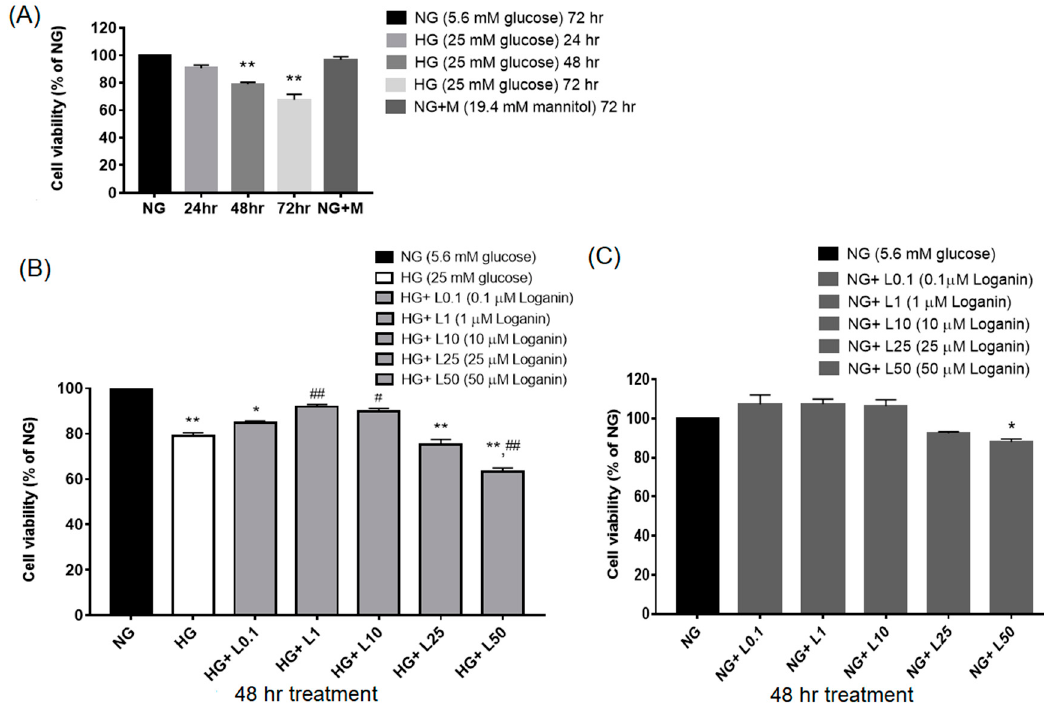
Figure 1. E ff ect of high glucose (HG) and loganin on the cell viability of rat RSC96 Schwann cells by Cell Counting Kit-8 (CCK-8) assay. ( A ) RSC96 cells were exposed to 25-mM HG for 24, 48 and 72 h. 5.6-mM NG + 19.4-mM mannitol for 72 h incubation was used as an osmotic control. * p < 0.05, ** p < 0.01, compared with 5.6-mM normal glucose (NG); ( B ) The e ff ect of di ff erent concentrations (0.1, 1, 10, 25, 50 µ M) of loganin was incubated for 48 h on the viability of 25-mM-HG-treated RSC96 cells; ( C ) e ff ect of di ff erent concentrations of loganin was incubated for 48 h on the viability of 5.6-mM-NG-treated RSC96 cells. * p < 0.05 and ** p < 0.01 vs. normal glucose (NG); # p < 0.05 and ## p < 0.01 vs. high glucose (HG).